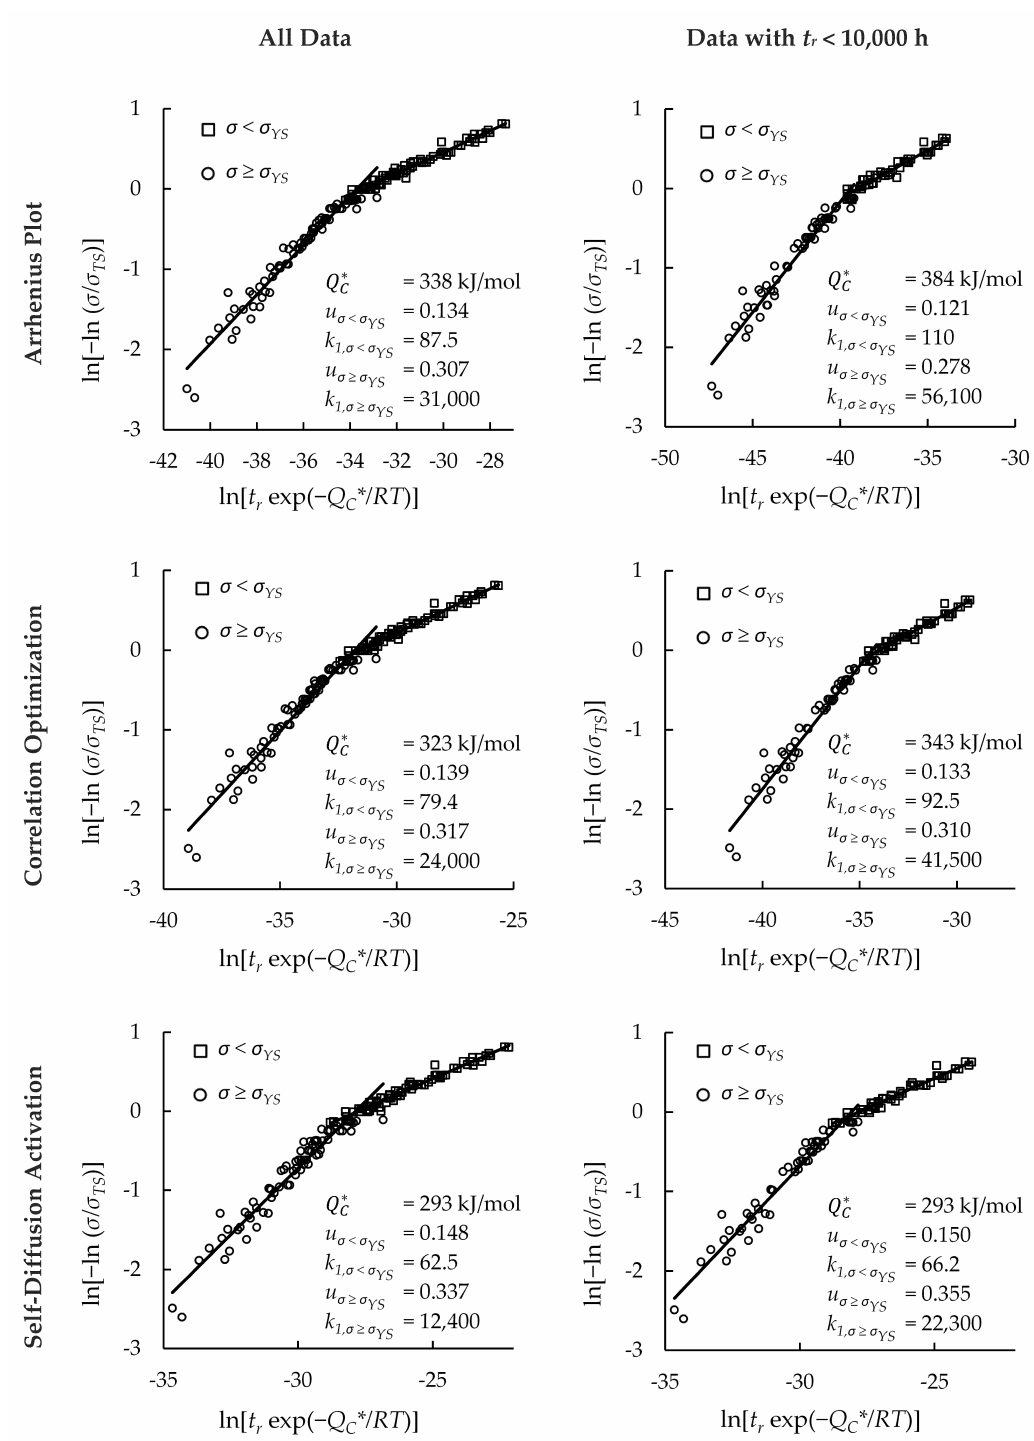
Figure A5. The effect of region-splitting on the goodness of fit of Wilshire plots for Sanicro 25.